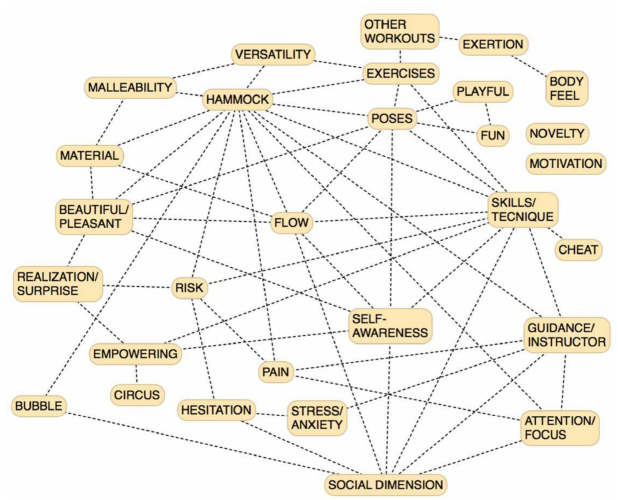
Figure 12. Representation of the resulting theme categories depicting strong inter-theme